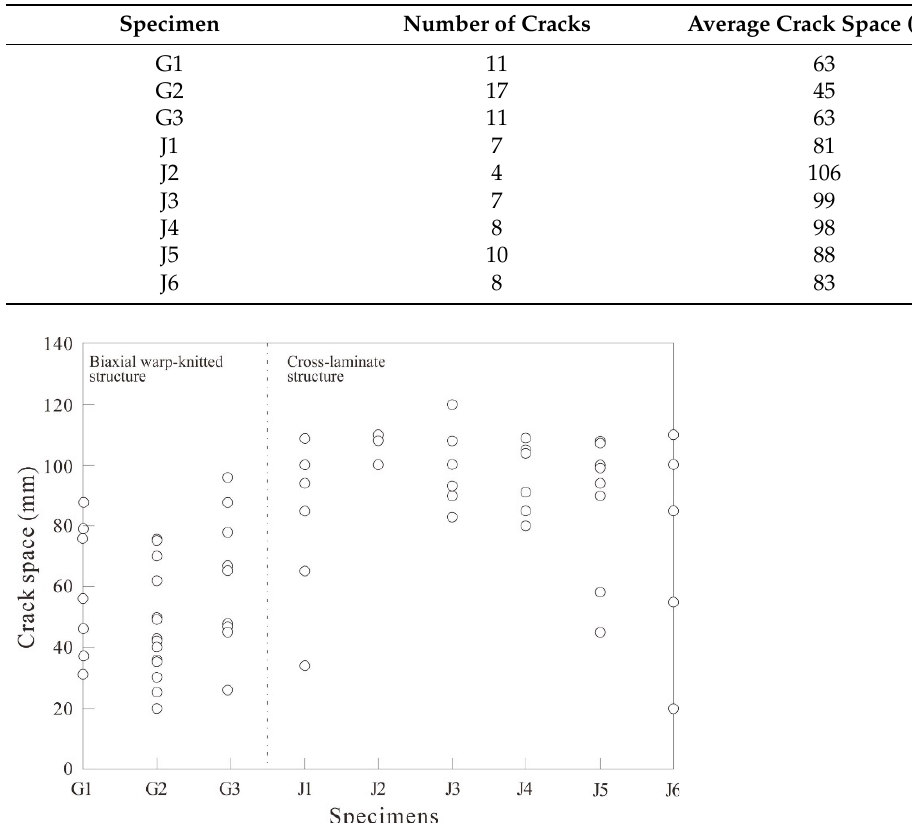
Figure 7. Specimen crack spaces.